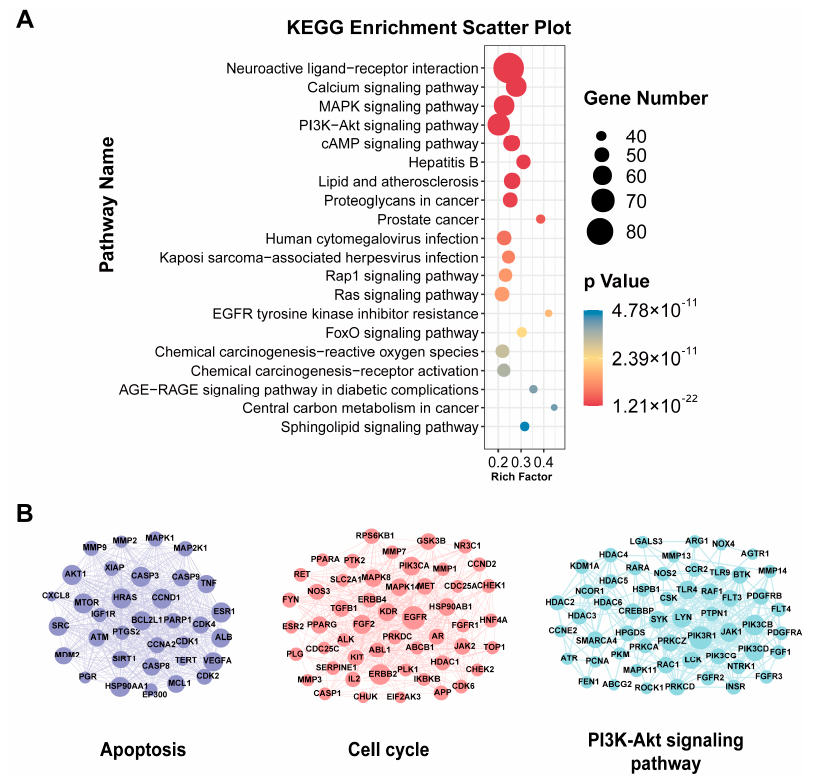
Figure 1. Enrichment analyses. ( A ) KEGG pathway enrichment analyses of SNP against depression, sorted by p -value. ( B ) The top 3 clusters of SNP, as identified using the MCODE algorithm. Table 2. Top 3 clusters identified from the MCODE results of SNP.